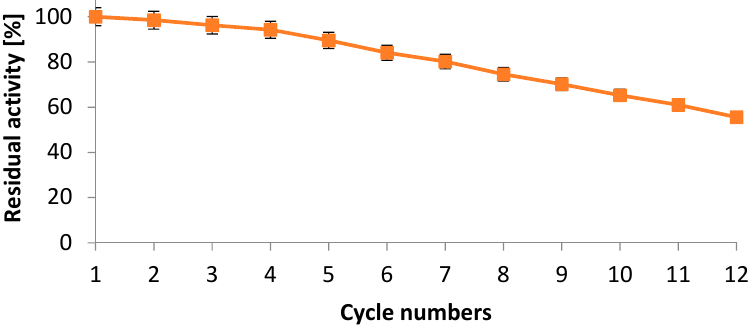
Figure 11. Reusability of NPST-AK15 protease immobilized within hollow core-mesoporous shell silica (HCMSS–NH 2 ) nanospheres.